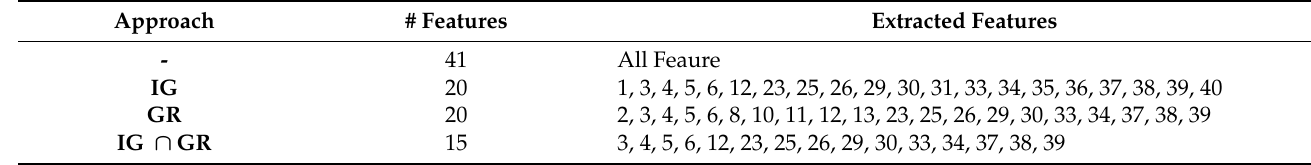
Table 3. Results of ranking feature